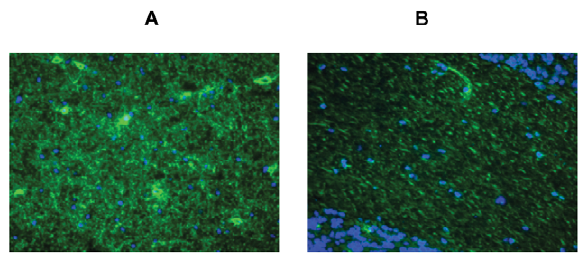
Figure 3. ‘‘Typical’’ (A) and ‘‘atypical’’ (B) white matter fluorescence staining as observed with anti-AQP4 positive NMO (A) and anti-AQP4 negative MS (B) human serum samples, respectively. Bound IgG was visualized using secondary antibodies labeled with FITC (green). Cell nuclei, stained with DAPI, are shown in blue. Magnification 40 6 . NMO: neuromyelitis optica; MS: multiple sclerosis; DAPI: 4,6-diamidino-2-phenylindole; FITC: Fluorescein isothiocyanate.